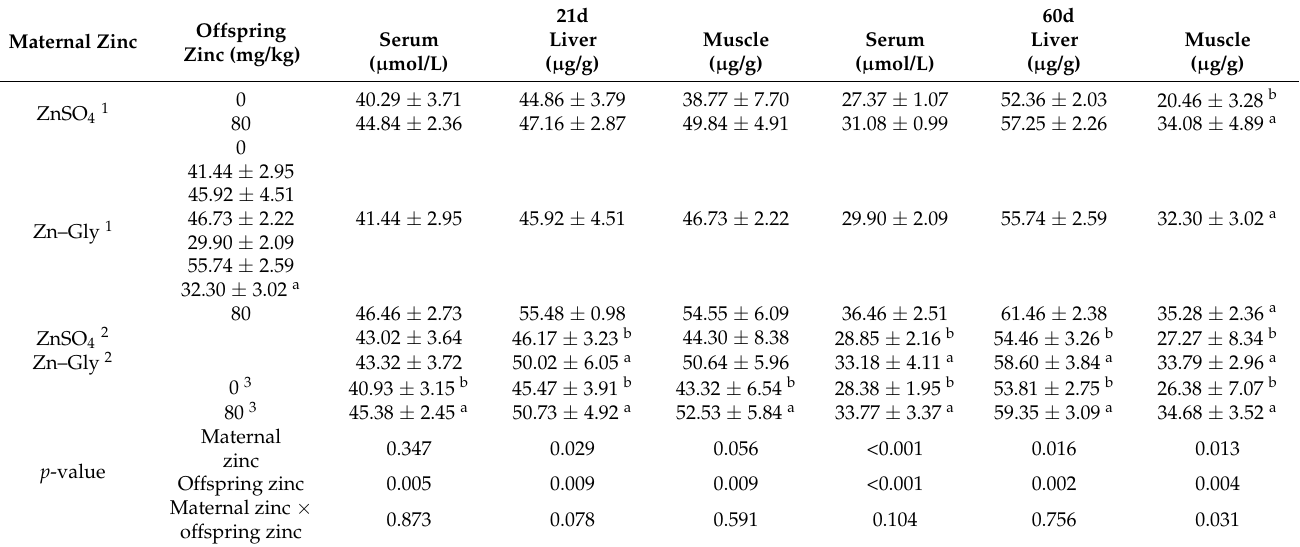
Table 4. Effects of maternal Zn in conjunction with their offspring dietary Zn supplementation on the Zn content in serum, liver, and muscle of offspring broilers (mean ± S.E.).